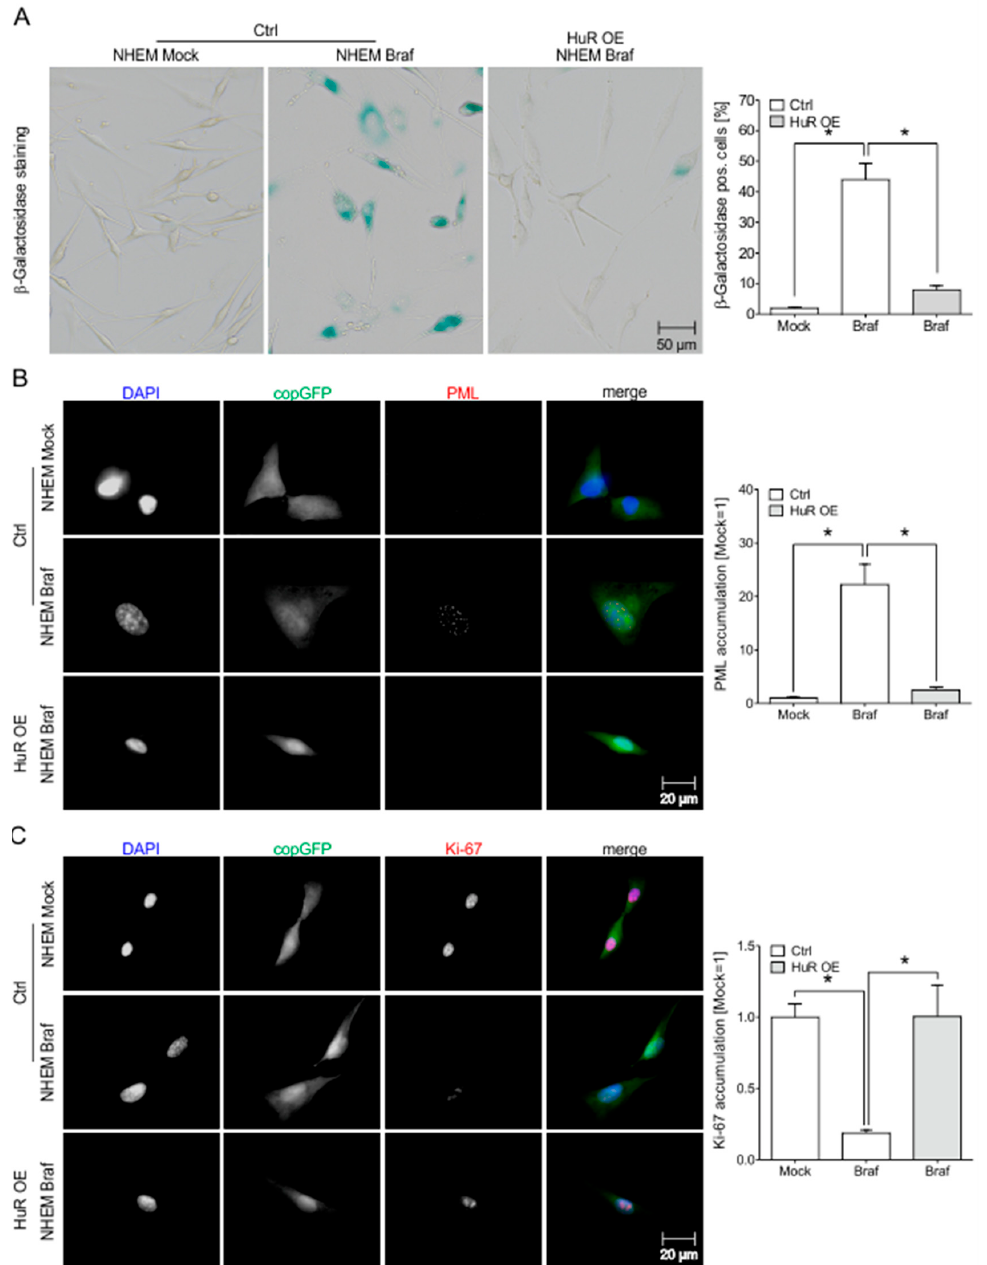
Figure 6. HuR overexpression leads to a reduction of senescence characteristics in NHEM Braf V600E cells. ( A ) Exemplary images of light microscopic examination of SA- β -galactosidase staining in NHEM Mock, NHEM Braf V600E , and NHEM Braf V600E / HuR OE cells (left). The percentages of SA- β -galactosidase positive cells (blue) were calculated (right) (Mock = 1). ( B ) Exemplary images of PML immunofluorescence staining of NHEM Mock, NHEM Braf V600E , and NHEM Braf V600E /HuR OE cells (red) and DAPI (blue) staining. CopGFP served as a transduction control (green) (left). The graph shows the nuclear accumulation of PML (Mock = 1) (right). For better recognition, colors are only shown in the overlay, not in single pictures. ( C Exemplary images of Ki-67 immunofluorescence staining of NHEM Mock, NHEM Braf V600E , and NHEM Braf V600E /HuR OE cells (red) and DAPI (blue) staining. CopGFP served as a transduction control (green) (top). The graph shows the accumulation of Ki-67 (Mock = 1) (bottom left). For better recognition, colors are only shown in the overlay, not in single pictures. *A p -value of <0.05 was considered statistically significant.